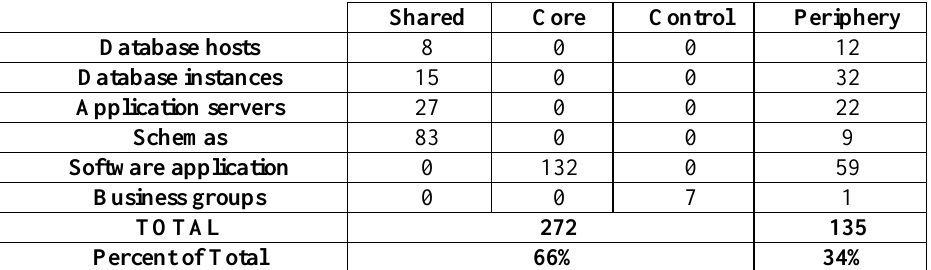
Table 1 . Distribution of Components in the Architecture by Layer and Category Shared Core Control Periphery Database